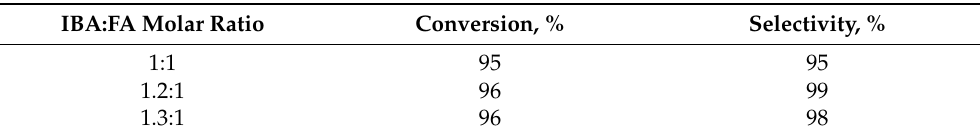
Table 1. The effect of IBA:FA molar ratio on hydroxypivaldehyde synthesis. Reaction conditions: 40 wt.% K 2 CO 3 ; PEG 600-PS, 0.5 mol%; 40 °C; 600 rpm; 2 h. Each experiment was performed three times.